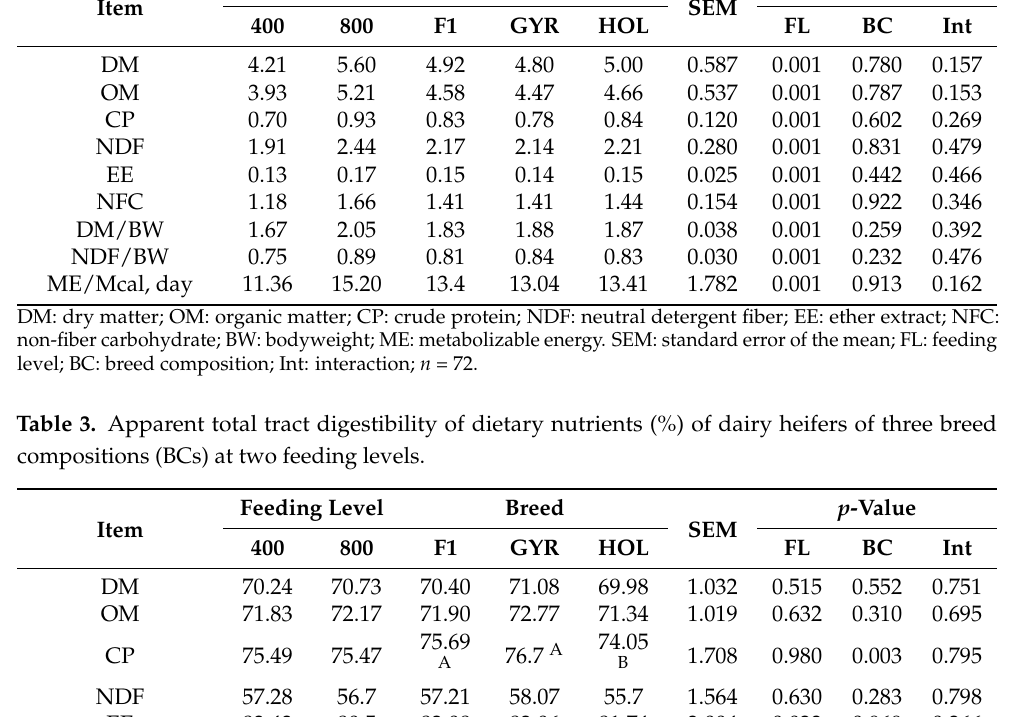
Table 2. Nutrients intake (kg/d) of dairy heifers of three breed compositions (BC) at two feeding levels. Feeding Level Breed Item 400 800 F1 GYR